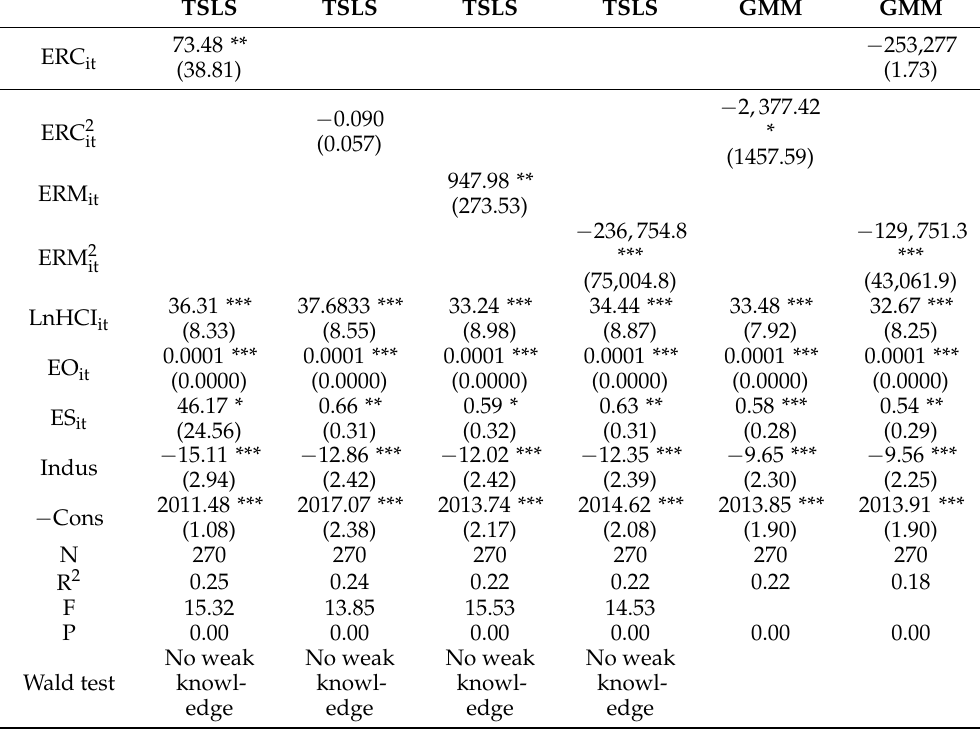
Table 11. Robustness test